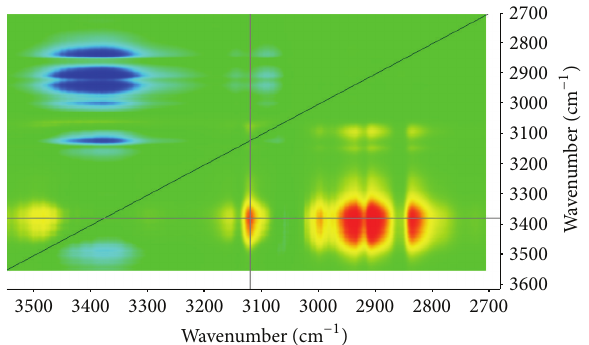
Figure 5: Two-dimensional FTIR correlation analysis for 2% cel- lulose in AMIMCl solution. Asynchronous spectrum on heating. Spectral range from 2700 to 3600 cm −1